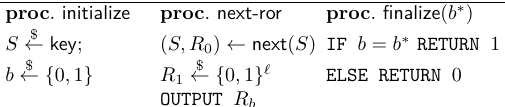
Figure 3: Procedures in Security Game SPR